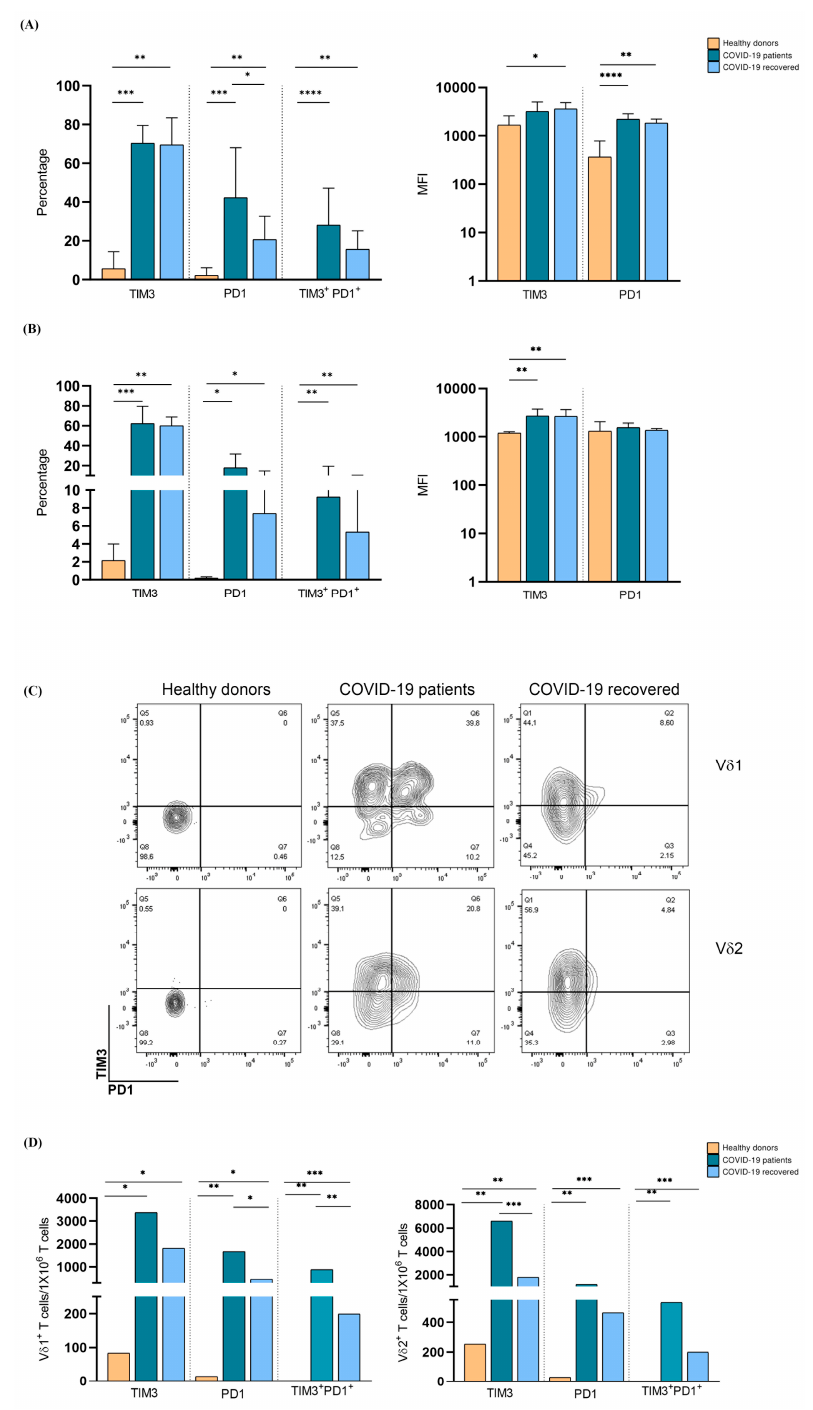
Figure 3. Analysis of exhaustion-marker expression by circulating V δ 1+ and V δ 2+ T lymphocytes